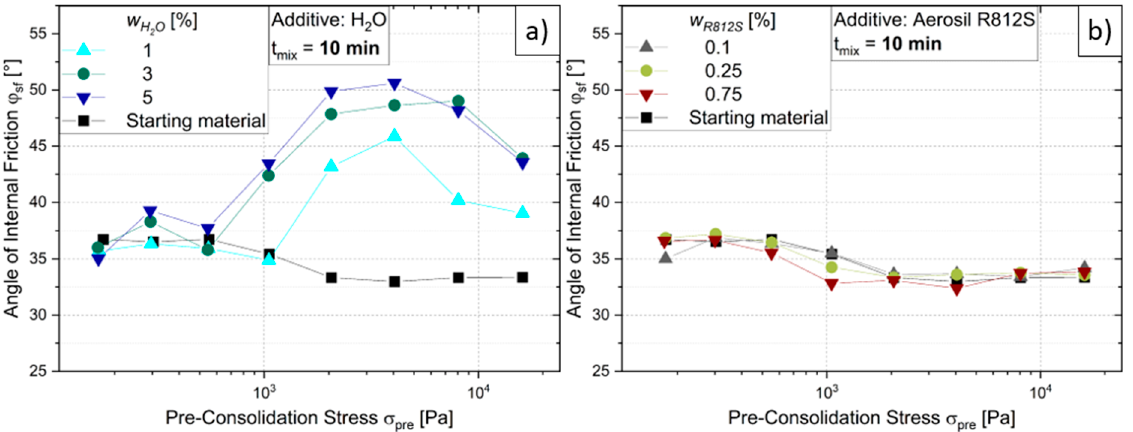
Figure 6. Angle of internal friction at steady-state flow in dependence of the consolidation stress for ( a ) coarse sand as well as mixtures of coarse sand and water at: w H2O = 1%, w H2O = 3% and w H2O = 5%; ( b ) Coarse sand as well as mixtures of coarse sand and R812S at w R812S = 0.1%, w R812S = 0.25% and w R812S = 0.75%.